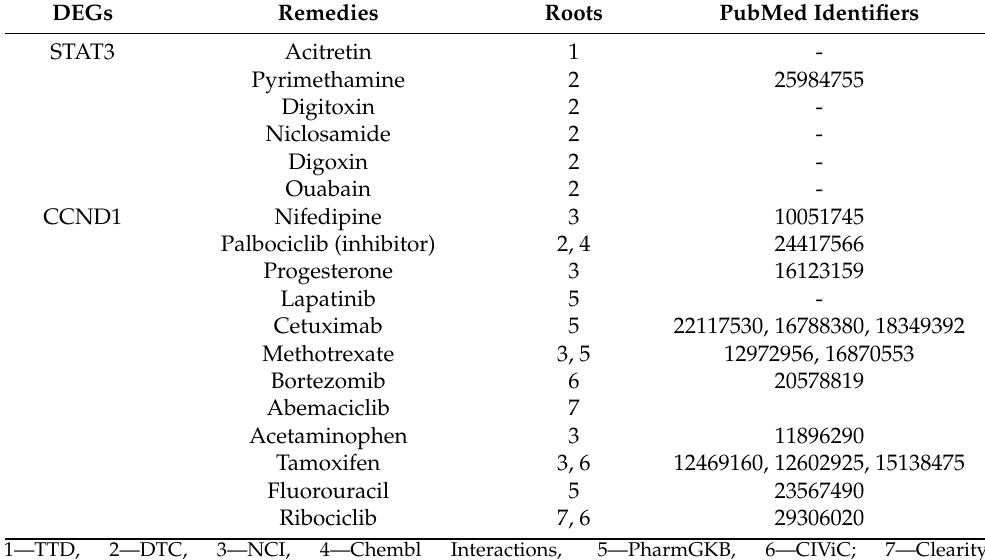
Table 6. Drugs that target hub genes.